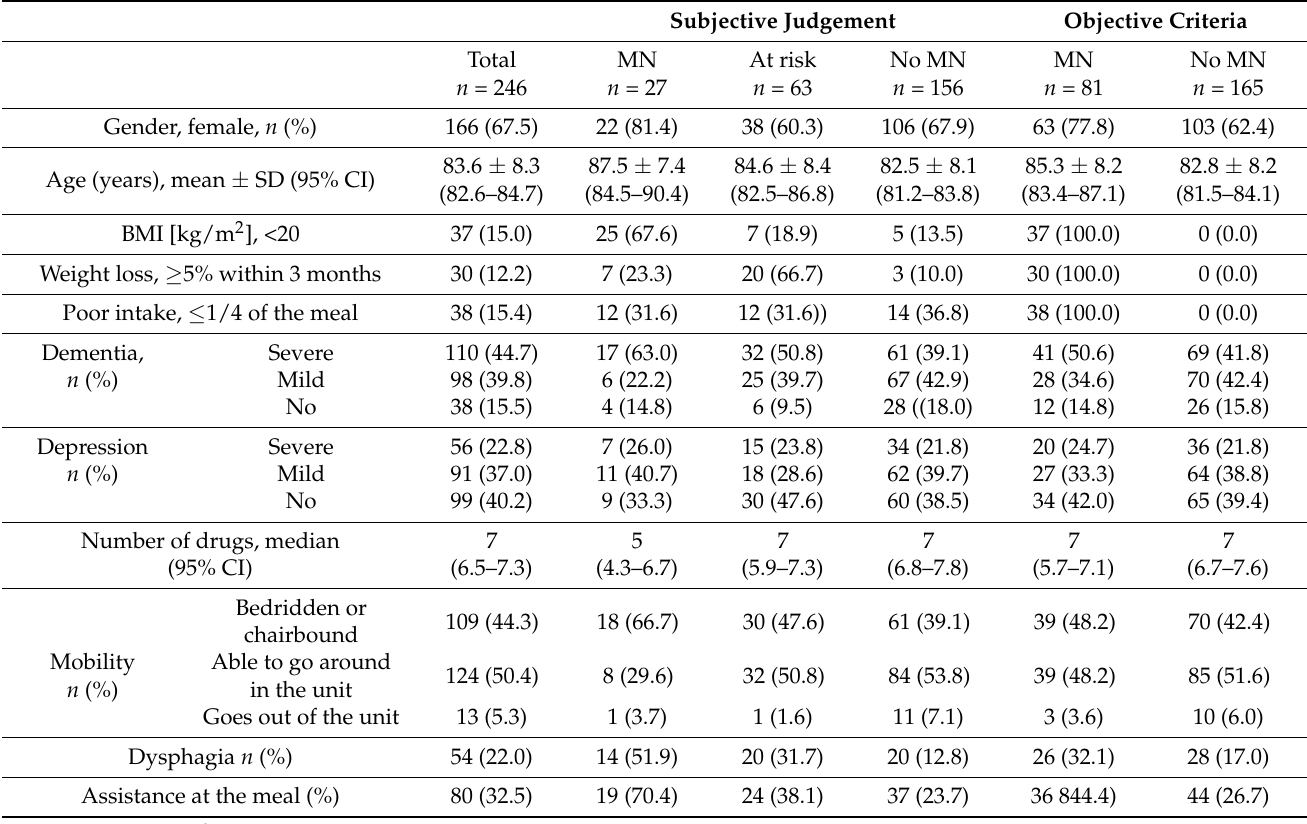
Table 1. Residents’ characteristics in the total sample, according to subjective judgement of malnutrition by nursing staff and according to objective rating * of malnutrition